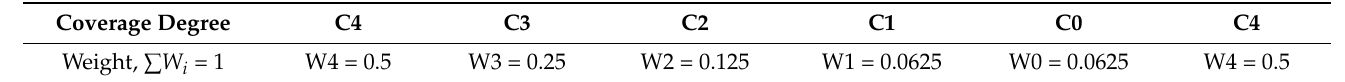
Table 1. Example of weight generation.